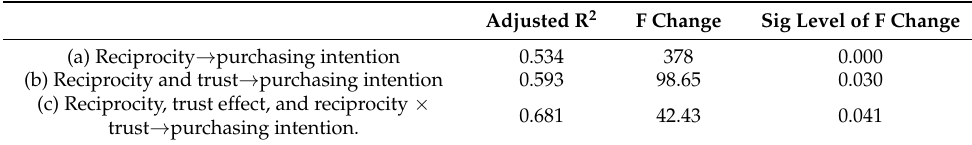
Table 8. The results of moderating effect of trust on purchasing intention.